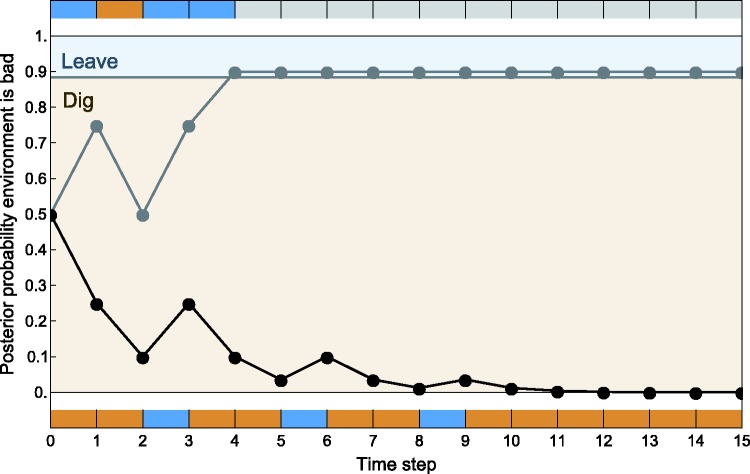
Two examples of optimal behavior by the fox. The vertical axis indicates the fox’s posterior subjective probability that it is in a bad environment. In the tan region, the fox should dig. In the blue region, the fox should avoid the burrow. The grey path and black path trace two possible outcomes of a fox’s foraging experience. The colored bars above and below the graph indicate the fox’s experience along the upper and lower paths, respectively: brown indicates that the fox found a rabbit and blue indicates that the fox found a badger. Along the grey path, the fox has a few bad experiences early. This shifts the fox’s subjective probability that the environment is bad upward, into the blue region. The fox stops sampling, its probability estimate stays fixed, and learning halts. Along the black path, the fox finds two or more rabbits between each encounter with a badger. Its subjective probability remains in the tan zone throughout, and the fox continues to sample—and learn—throughout the experiment